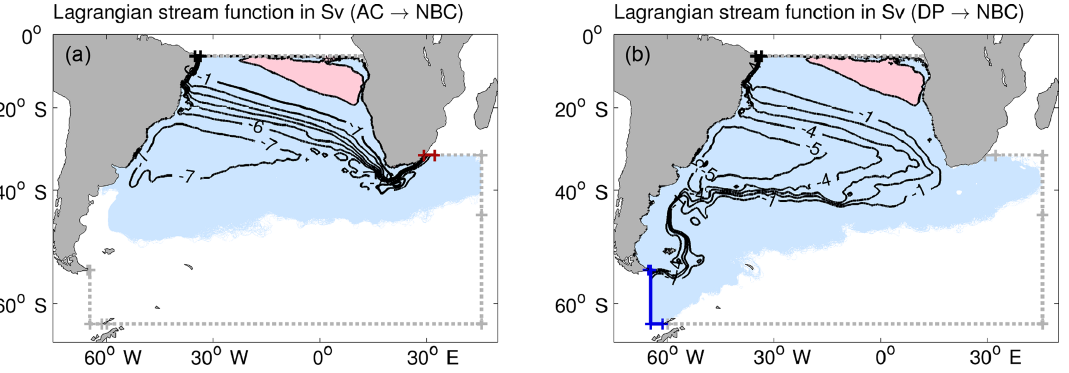
Figure 5. Mean Lagrangian stream function from all 10 REF experiments representing net volume transport pathways between (a) AC or (b) DP and the NBC; contour intervals of